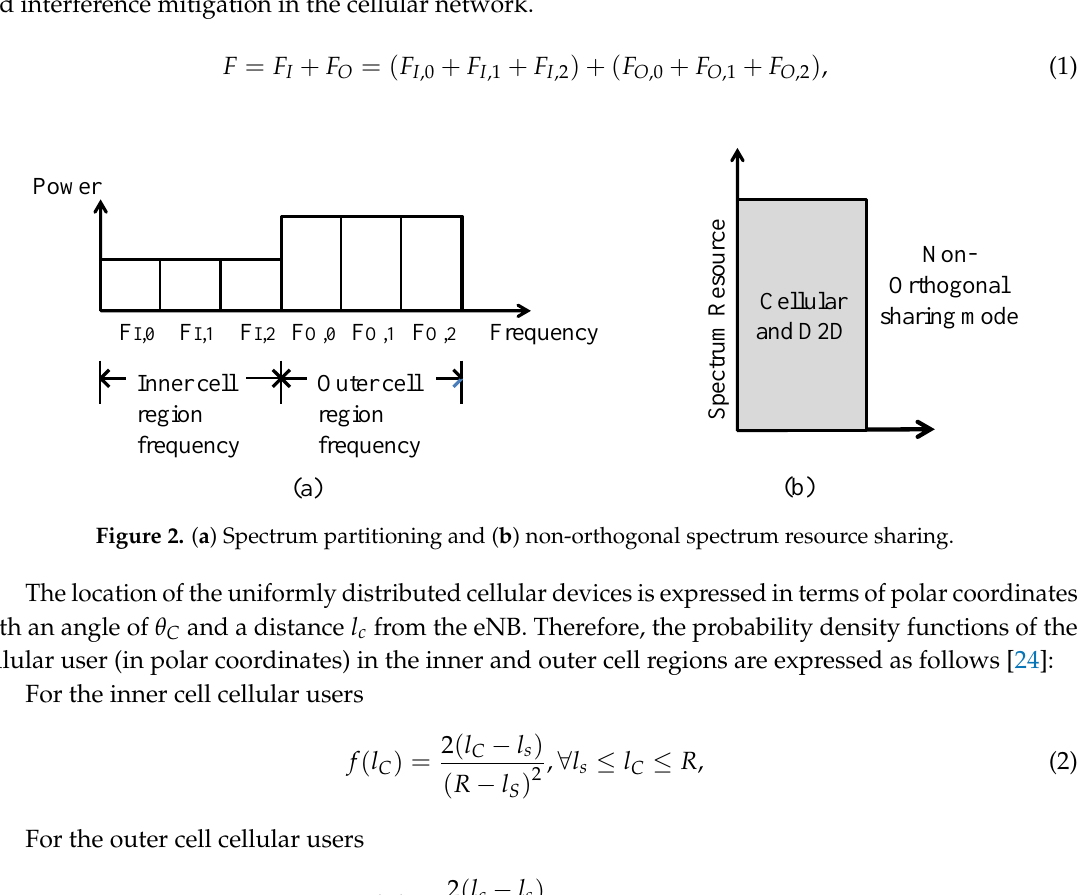
Figure 1. Device-to-device (D2D) communication network model.